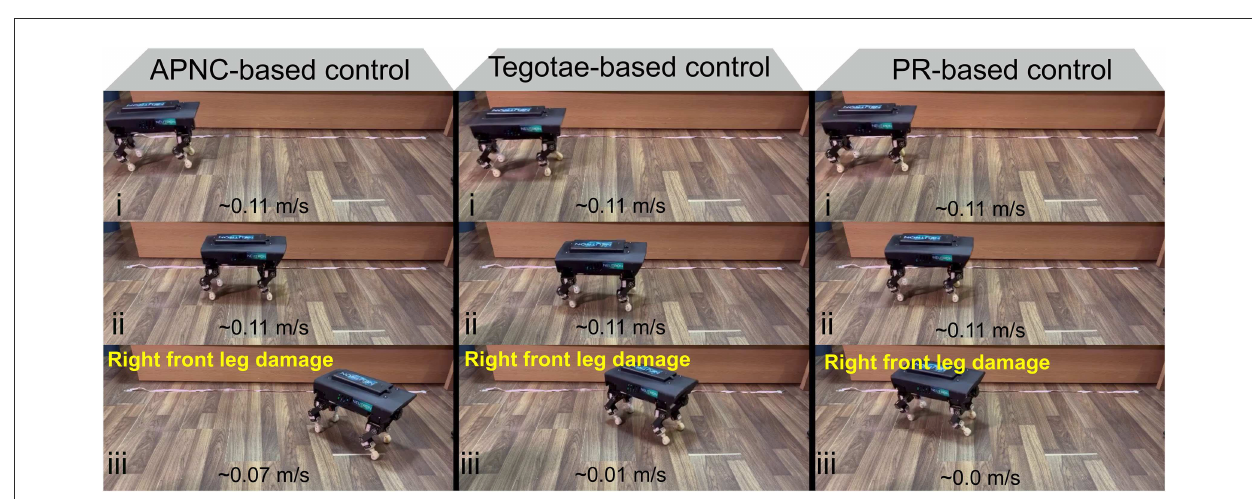
FIGURE8 The three control methods were evaluated in a walking experiment conducted using the real robot with damaged leg. The APNC-based control enabled the robot to walk at the highest speed (0.07 m/s). A video clip of this experiment can be viewed at https://www.manoonpong.com/